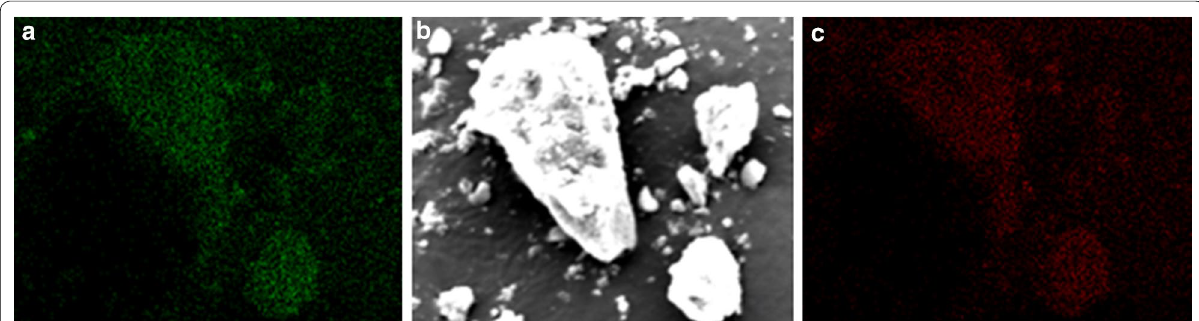
Fig. 5 Qualitative mapping of 0.5 Zn/Mg surface. a Mg mapping; b SEM image (